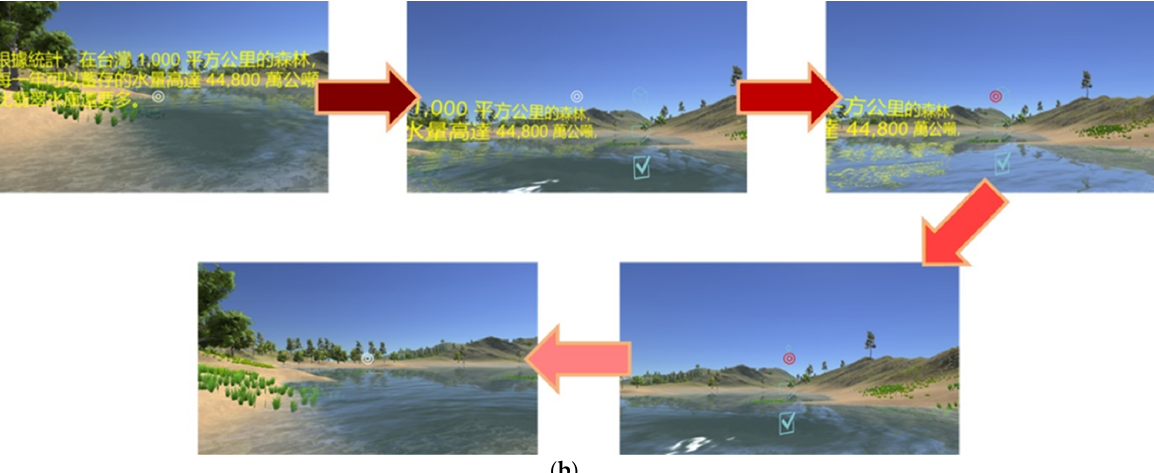
Figure 8. ( a ) The procedure of showing text annotations; ( b ) The procedure of hiding text annotations. 3.